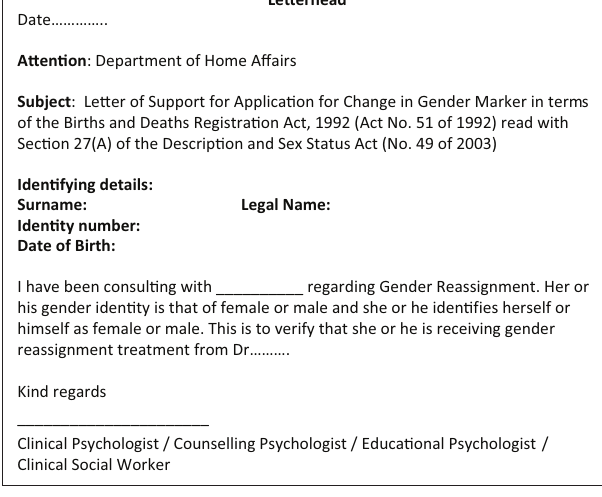
Le(cid:29)erhead